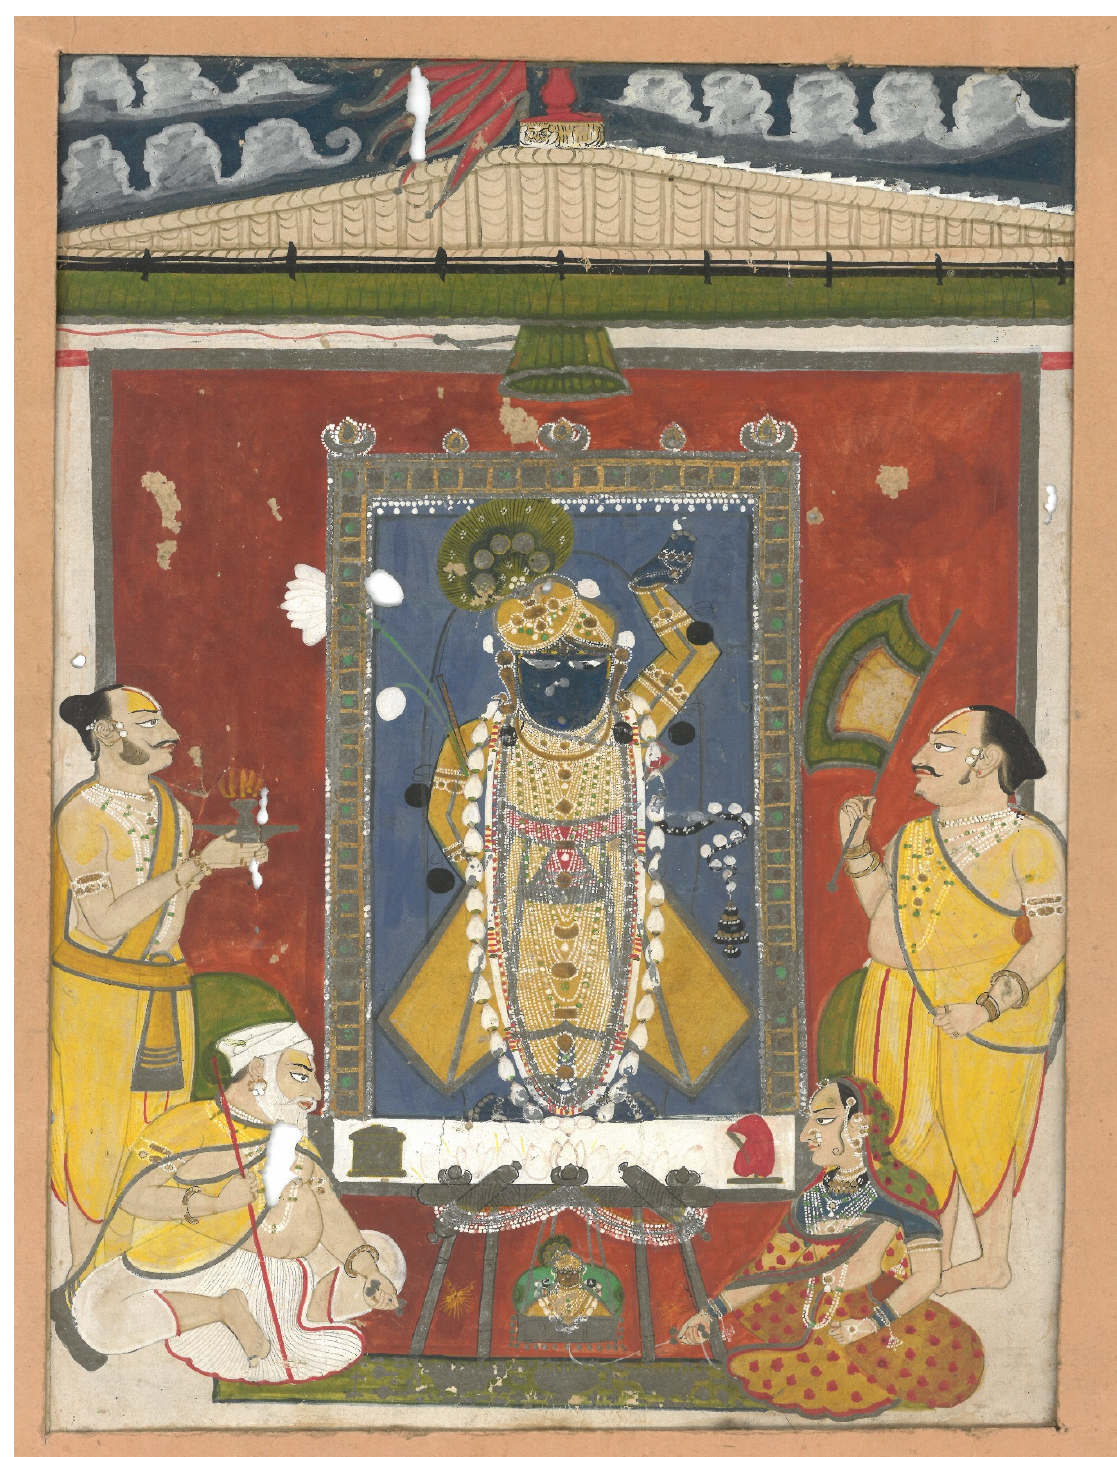
Figure 2. The image of Ś r ī N ā th under worship. In front of the image, there is a small cradle or swing with an image of young Krishna. Worshippers pull the string to rock young Krishna. The priest on the left offers an ā rat ī light. Rajasthan late 18th century (private collection).